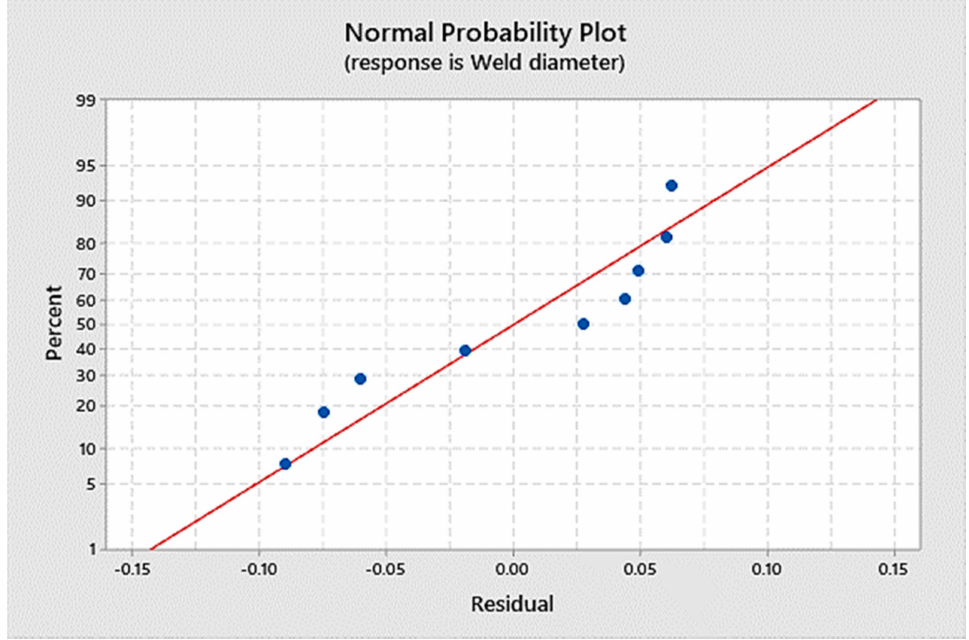
Figure 7. Normal probability plot as the response of the weld